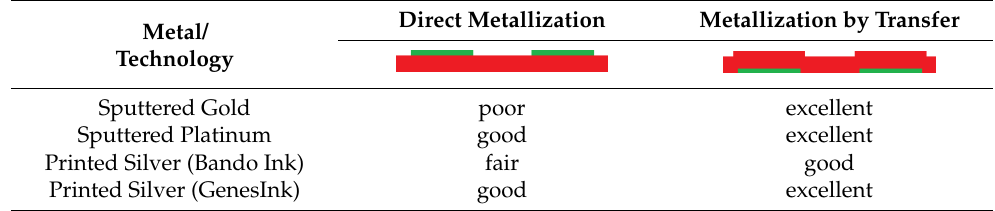
Table 4. Adhesion of metals on Parylene for direct metallization and metallization by the transfer process. Metal/